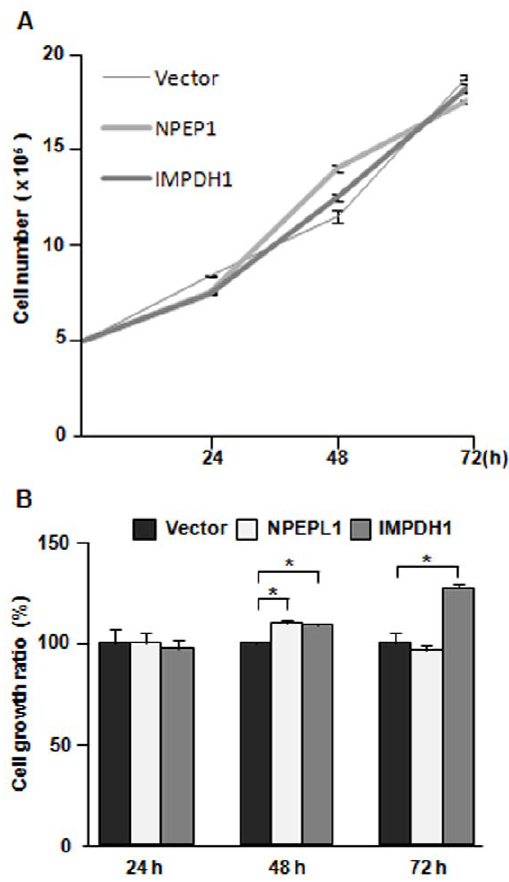
Figure 6. Effects of exogenous expression of target genes on cell growth of MCF-7. MCF-7 cells were transfected with the IMPDH1 , NPEPL1 cDNA expression vector or a control vector and then counted and split into multi-well plates at 24 hours after transfection. Cell viability was measured with the Trypan Blue excision test (A) and a WST- 1 cell proliferation assay (B) at 24, 48 and 72 hours after the split. For the WST-1 assay, the cell growth ratio (%) was calculated by comparing the viability of cells treated with the target genes compared with that of the cells treated with the control vector.